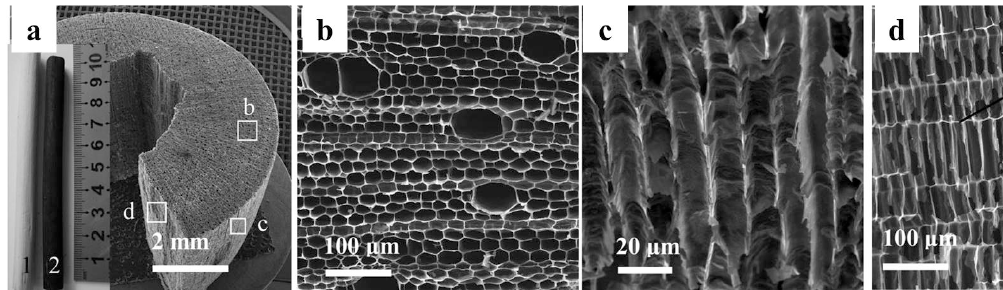
Figure 8. Images of 3D-KSC. ( a ) Overview image of a piece of cleaved 3D-KSC. The insets are photographs of kenaf stalk before (1) and after (2) carbonization; ( b ) Vertical sectioned SEM image magnified from position b; ( c ) SEM Image magnified from position c; ( d ) Longitudinal sectioned SEM image magnified from position d [102]. Reproduced with permission from Wiley.